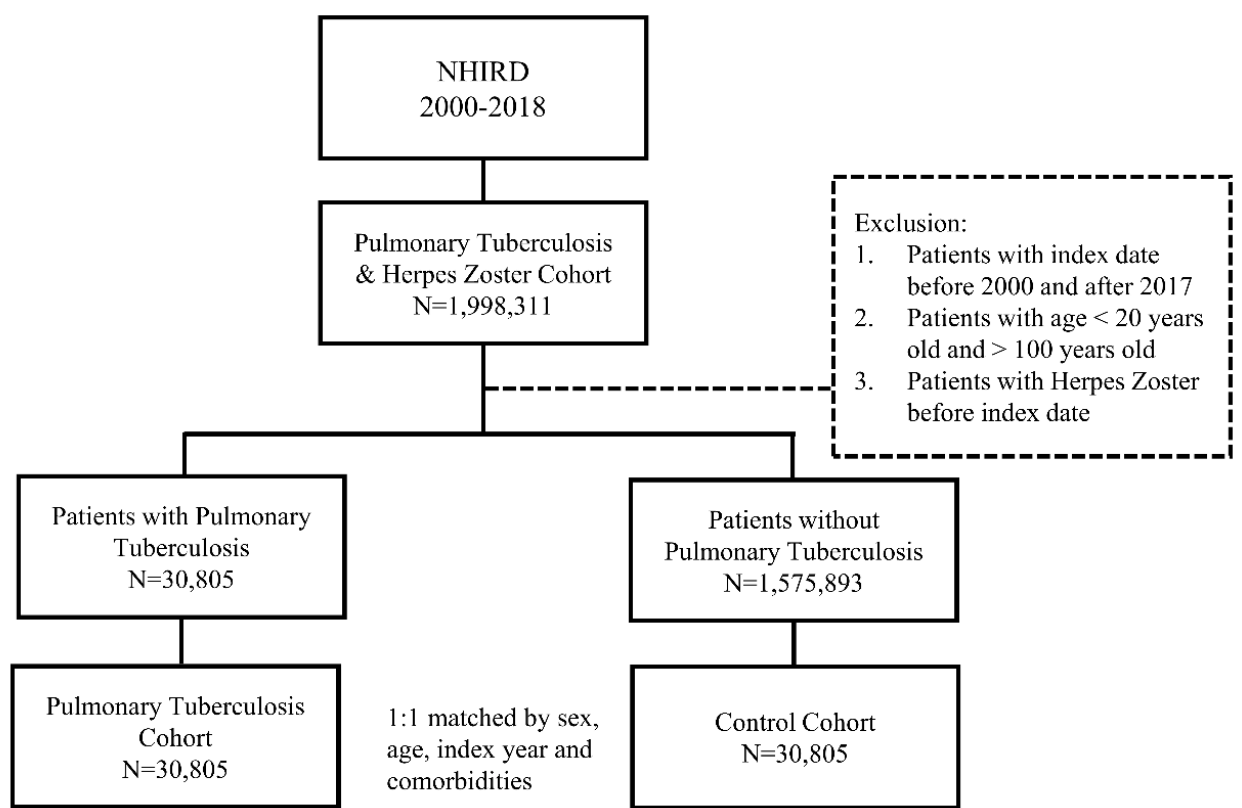
Figure 1. The flowchart of study sample selection from the National Health Insurance Research Database (NHIRD) of Taiwan.